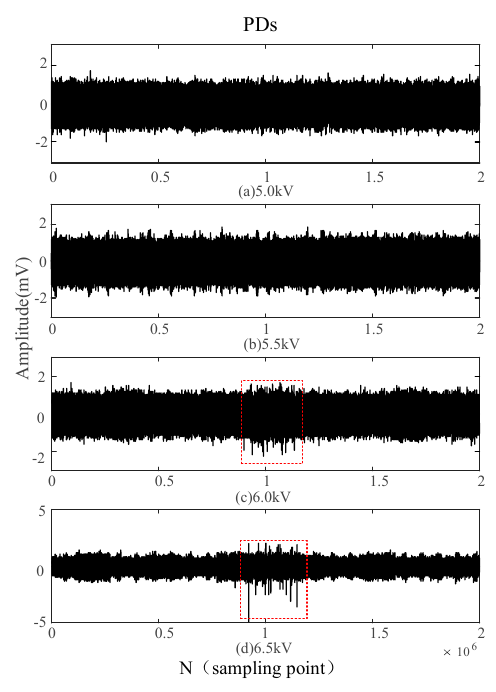
Figure 14. PDs detected by the built-in antenna under different voltages.